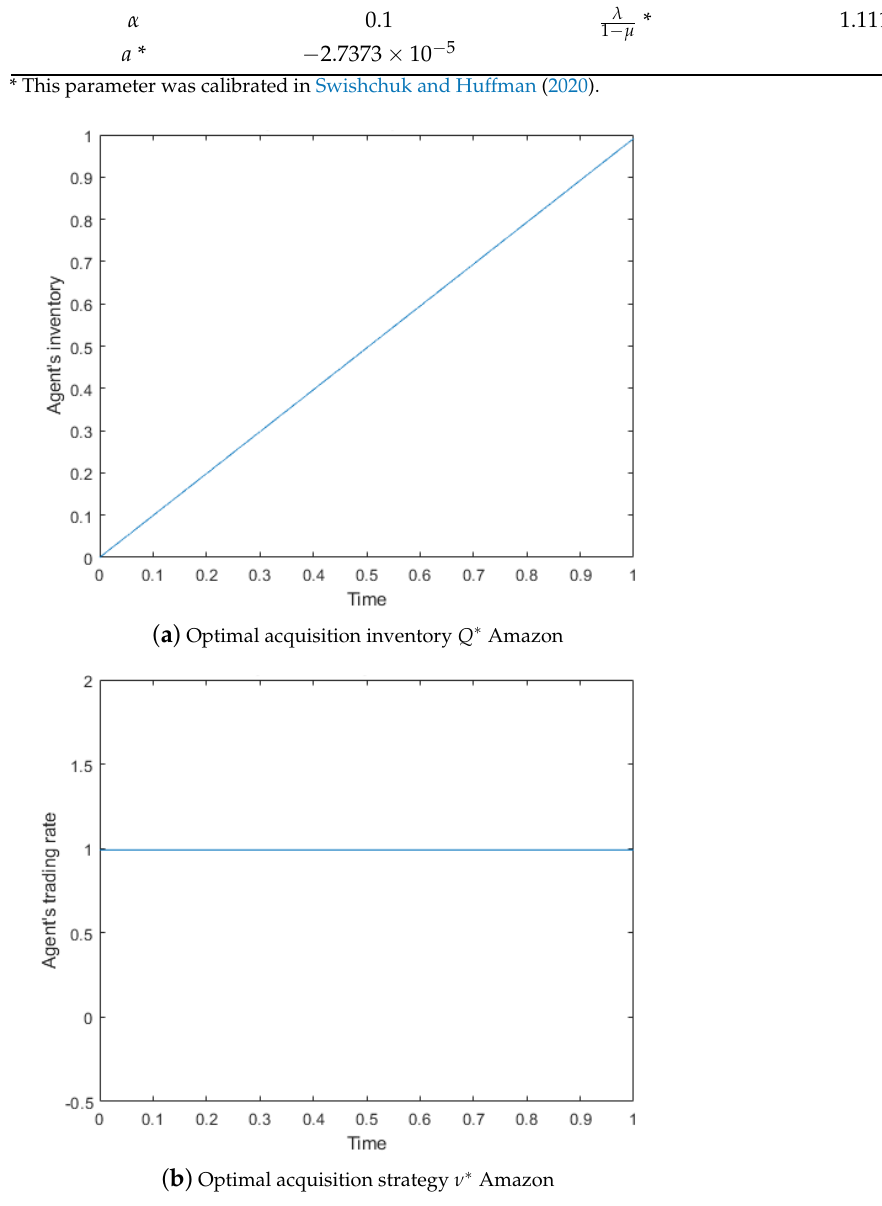
Figure 6. Optimal acquisition inventory and optimal acquisition strategy for Amazon stocks. ( a ) the inventory calculated with Equation (56), using the parameters in Table 6. ( b ) the optimal acquisition value calculated with Equation (57), using the parameters in Table